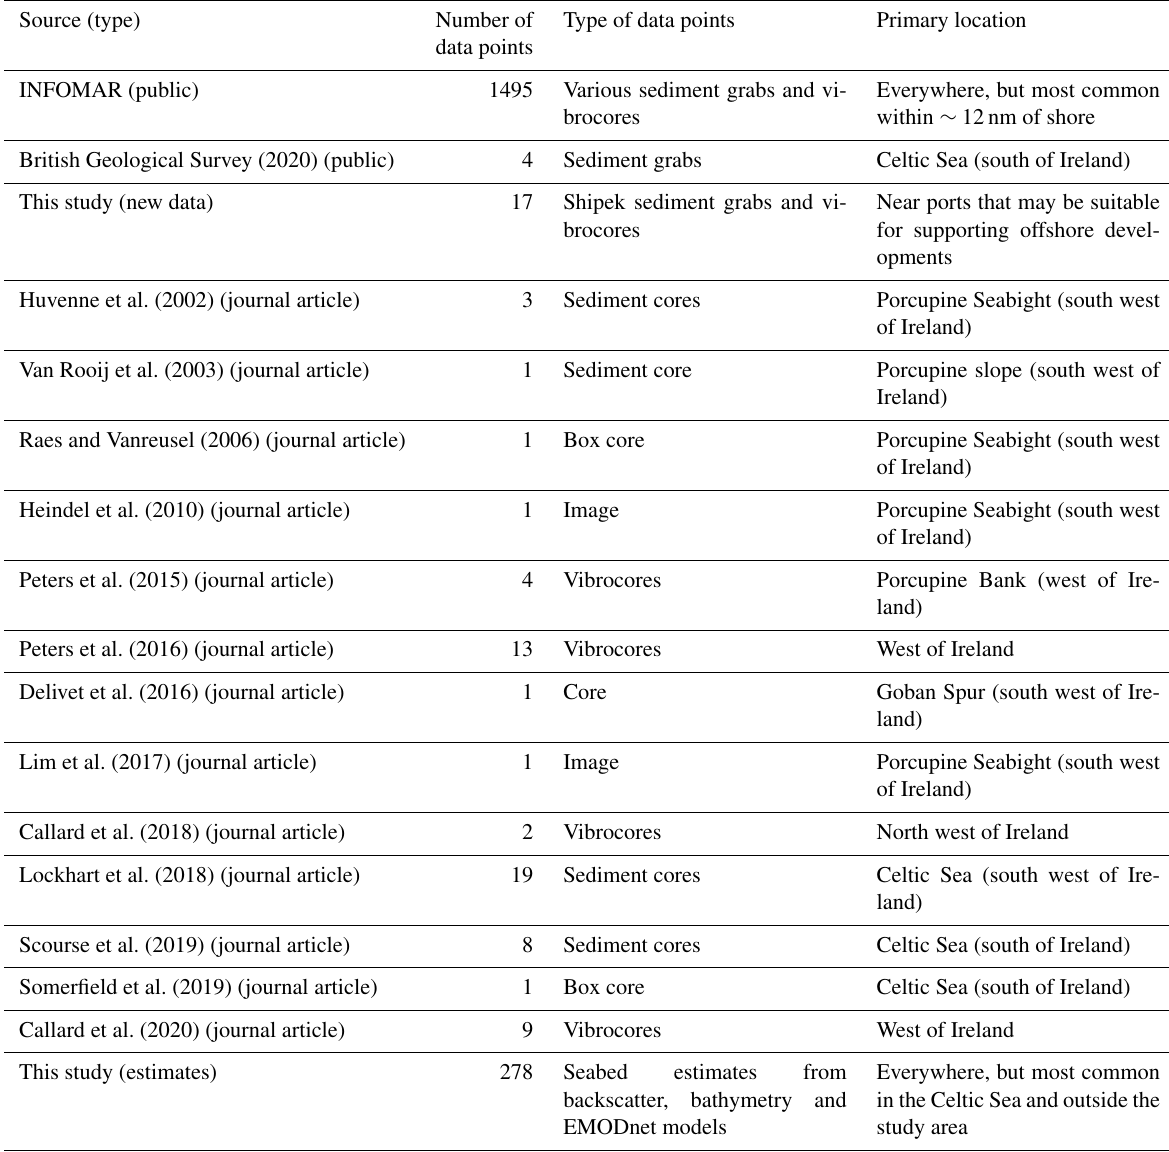
Table 2. Summary of data collection and estimation work.